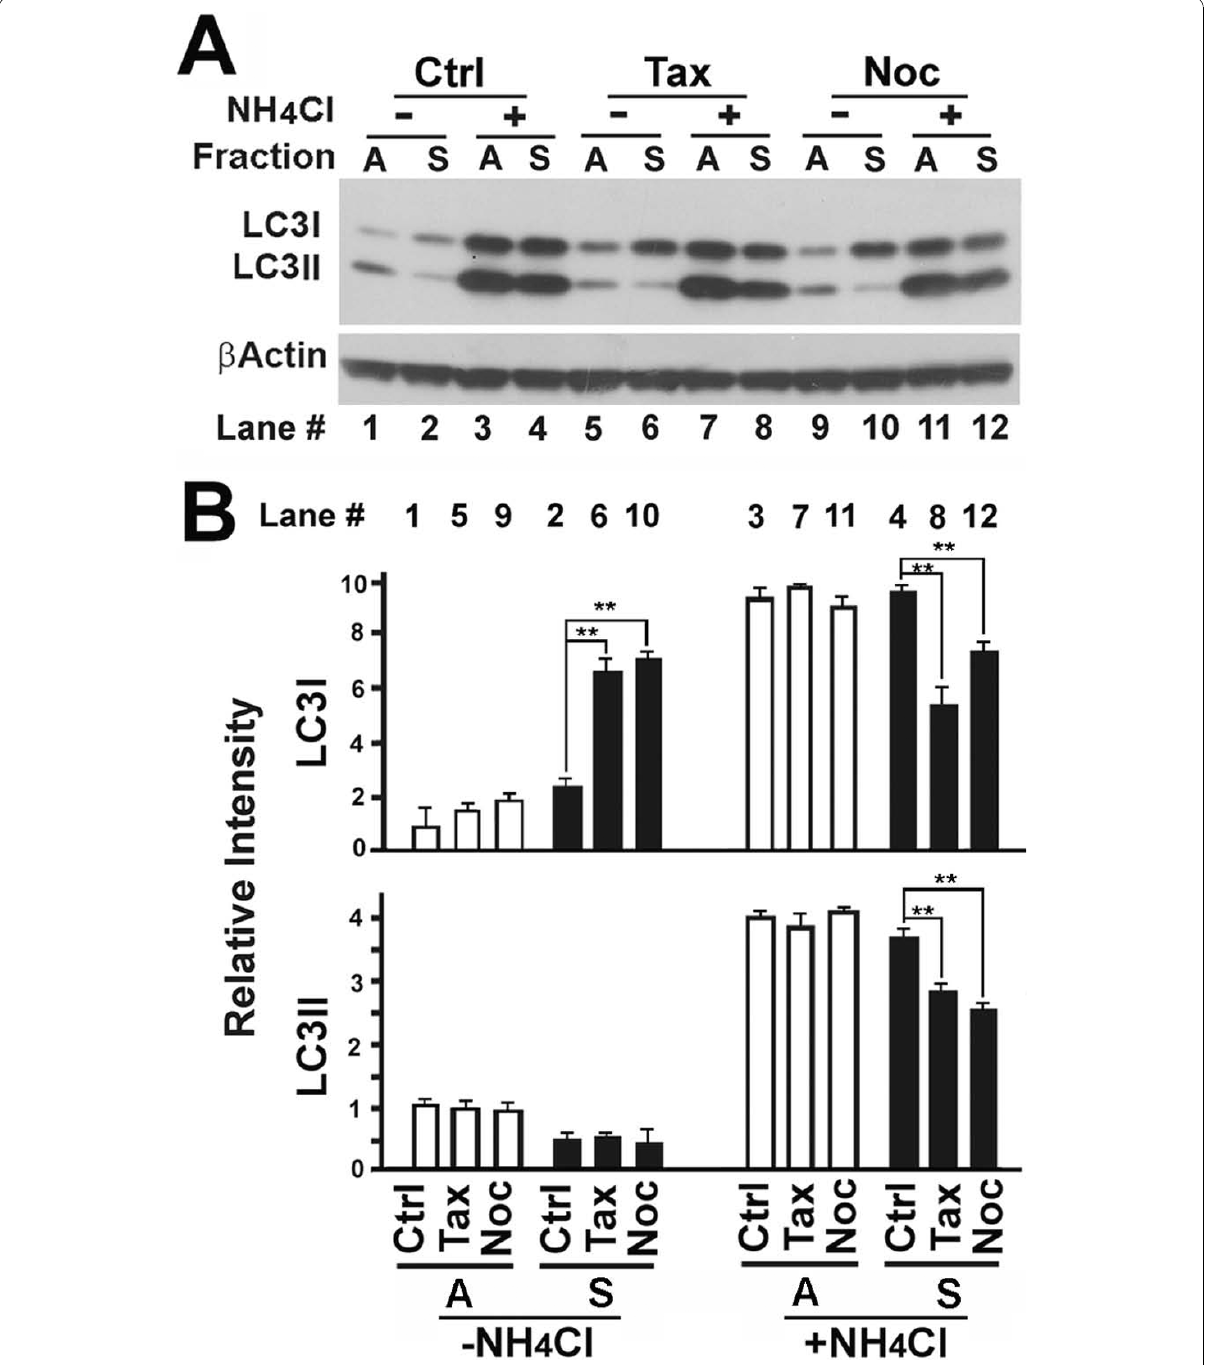
Figure 2 Interrupting the dynamics of regular microtubules with either nocodazole or paclitaxel impairs conversion of LC3I to LC3II only in mitotic cells . ( A ) Immunoblot of lysates of fractioned HeLa cells. Mitotic cells were enriched by synchronization with 2 mM thymidine for 20 hr followed by release from the thymidine blockade for 20 hr in the absence or presence of 10 μ M paclitaxel or nocodazole as described previously [40]. NH4Cl (20 mM) was added simultaneously with microtubule interfering agents. Loosely attached mitotic cells (S) were harvested by vigorous shake off from the remaining mixture (A) of interphase cells and mitotic cells attached to the dish. ( B ) The relative intensities of LC3I and LC3II bands were calculated from the scanned intensities of bands of three independent experiments as exemplified by immunoblot shown in (A). **, p < 0.01 as calculated by Student ’ s